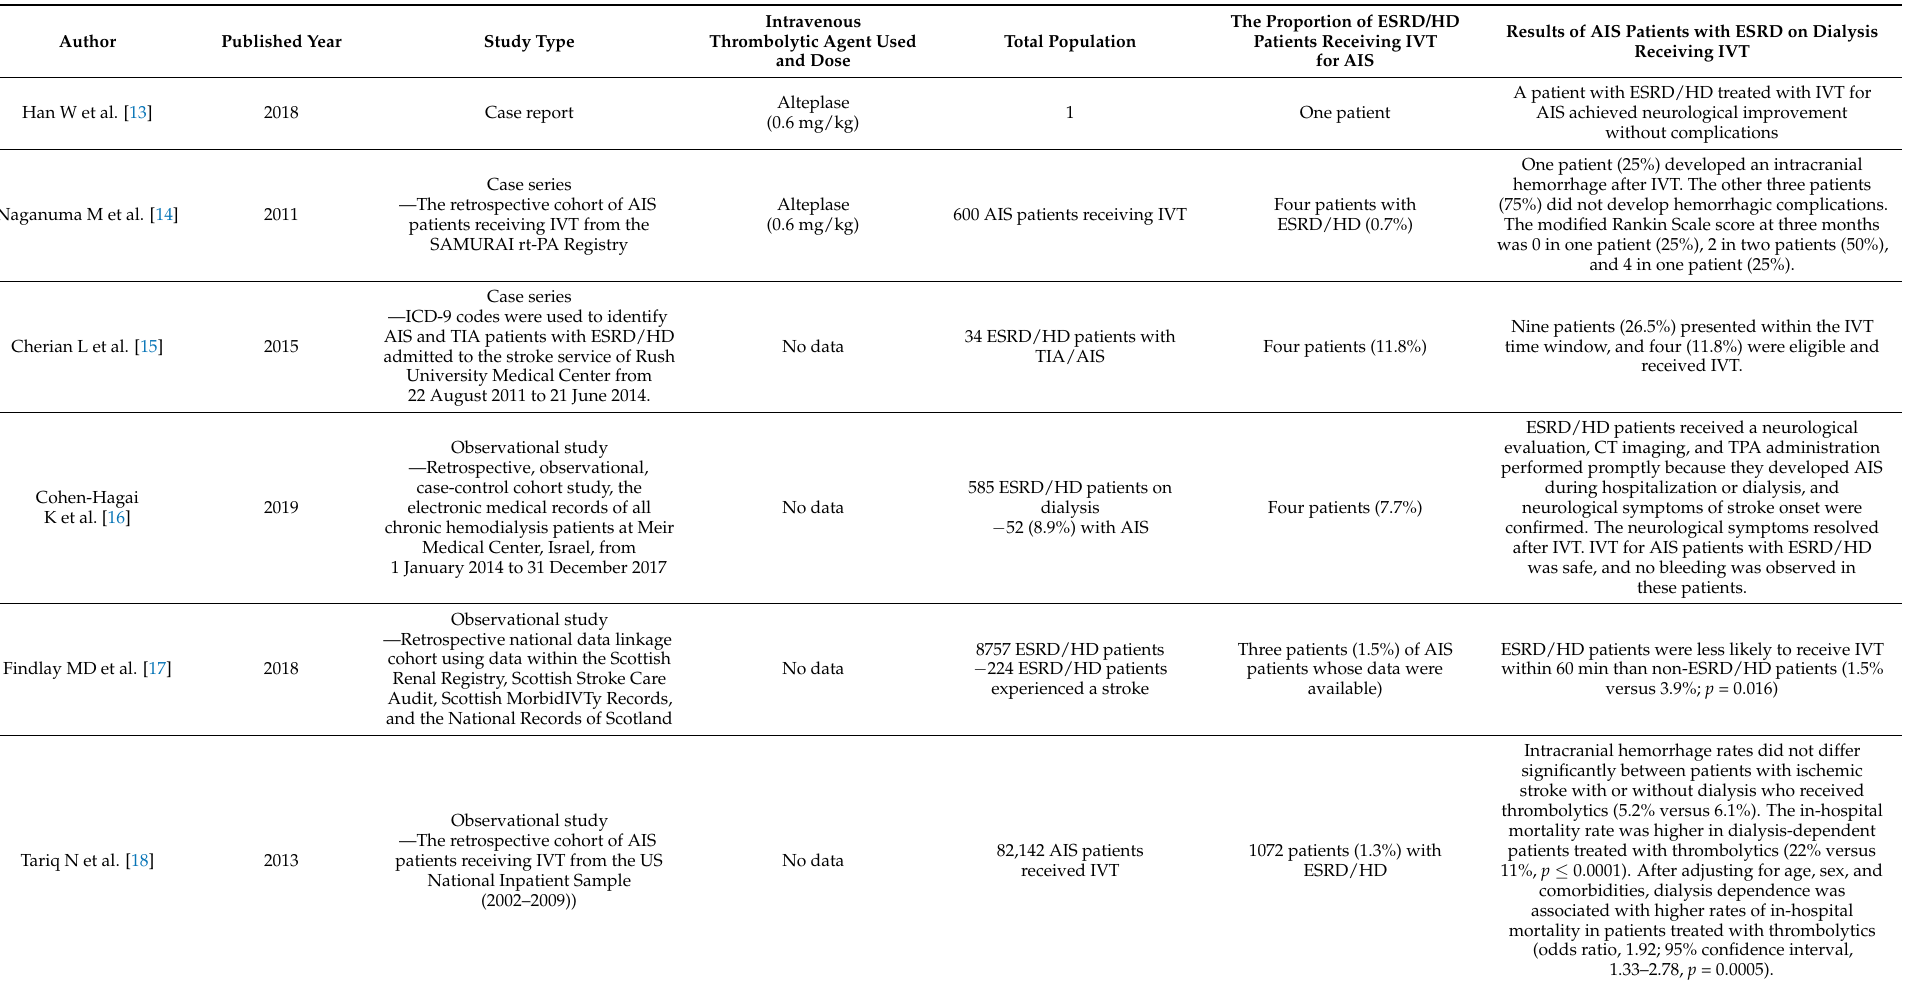
Table 1. Summary of studies